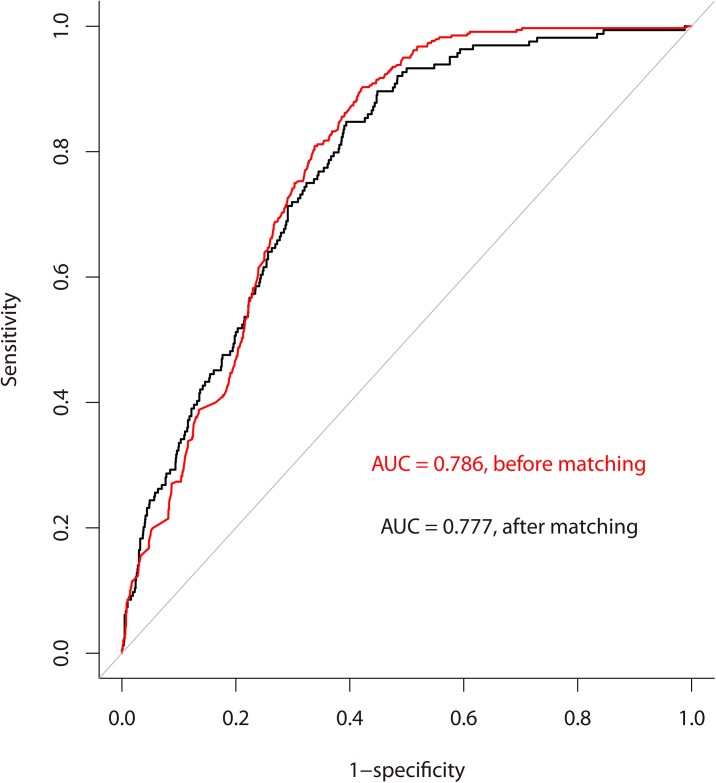
Area under the receiver operating characteristic curve (AUC) was 0.786 for the prediction of high cost (above US $4,721) among patients with advanced lung cancer in their last month of life.